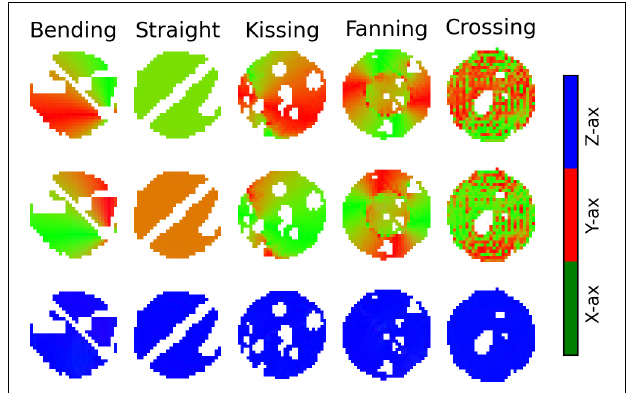
FIGURE 9 | Colour maps of the three orthogonal orientations defined by Bingham-Neurite orientation density and dispersion imaging (NODDI) in each phantom. Gaps in the images correspond to air bubbles and water-filled fiducials that were excluded with a manually drawn mask. The lines of masked out voxels in the bending and straight phantoms correspond to regions in which printer error deposed an unintended line of material between layers. Top row: The dominant orientation. Middle row: The primary dispersion orientation. Bottom row: The secondary dispersion orientation.